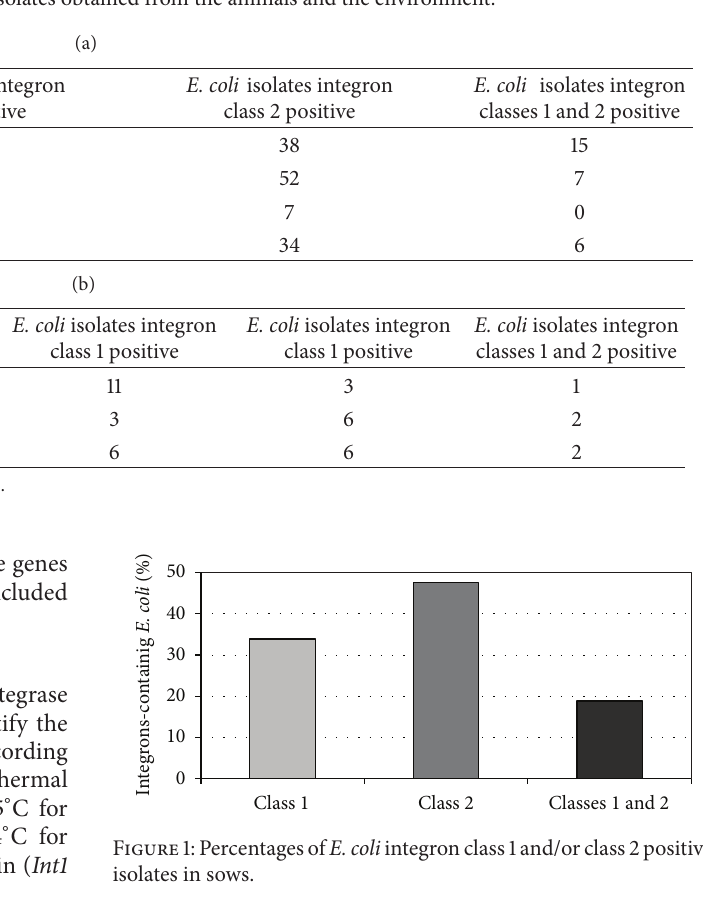
Table 2: Details of the number of isolates obtained from the animals and the environment.